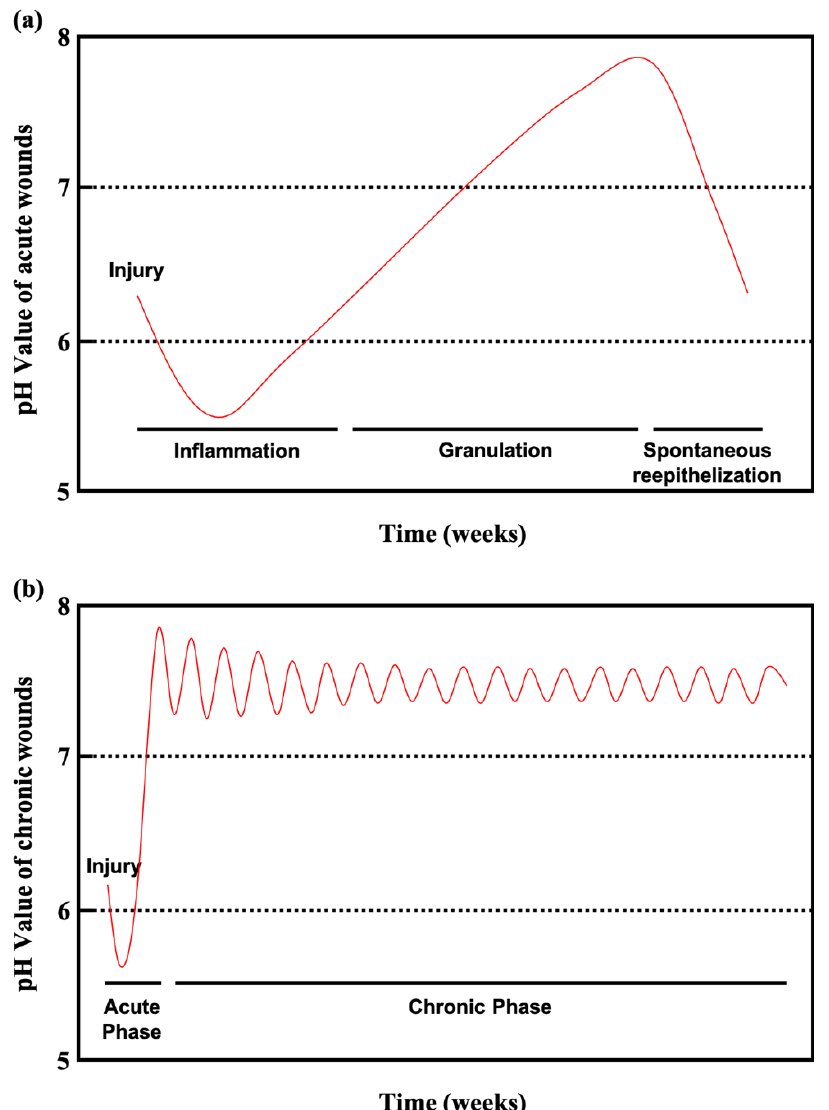
Figure 3. ( a ) Course of the pH milieu in acute wounds. ( b ) Course of the pH milieu in chronic wounds (adapted from [10]).